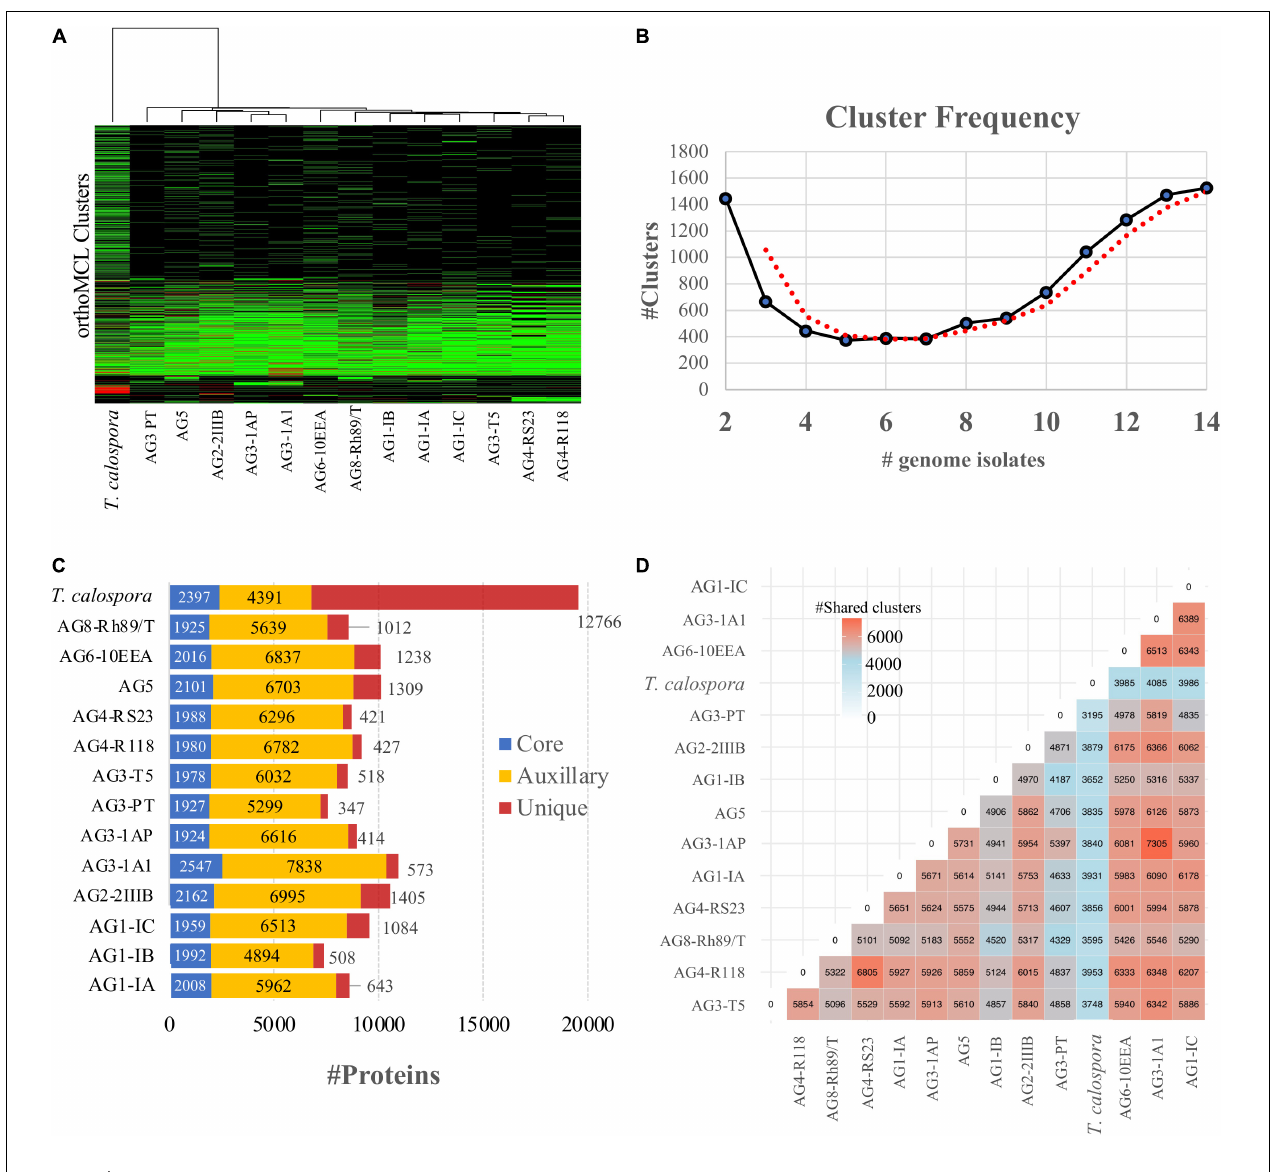
(excluding T. calospora , Supplementary Figure 4 ) in which the AG3-1A1 genome had the highest number of transcripts. Next, using OrthoMCL, the translated protein sequences in all genomes were clustered into orthologous groups, where each cluster of proteins represented a set of similar sequences likely to represent